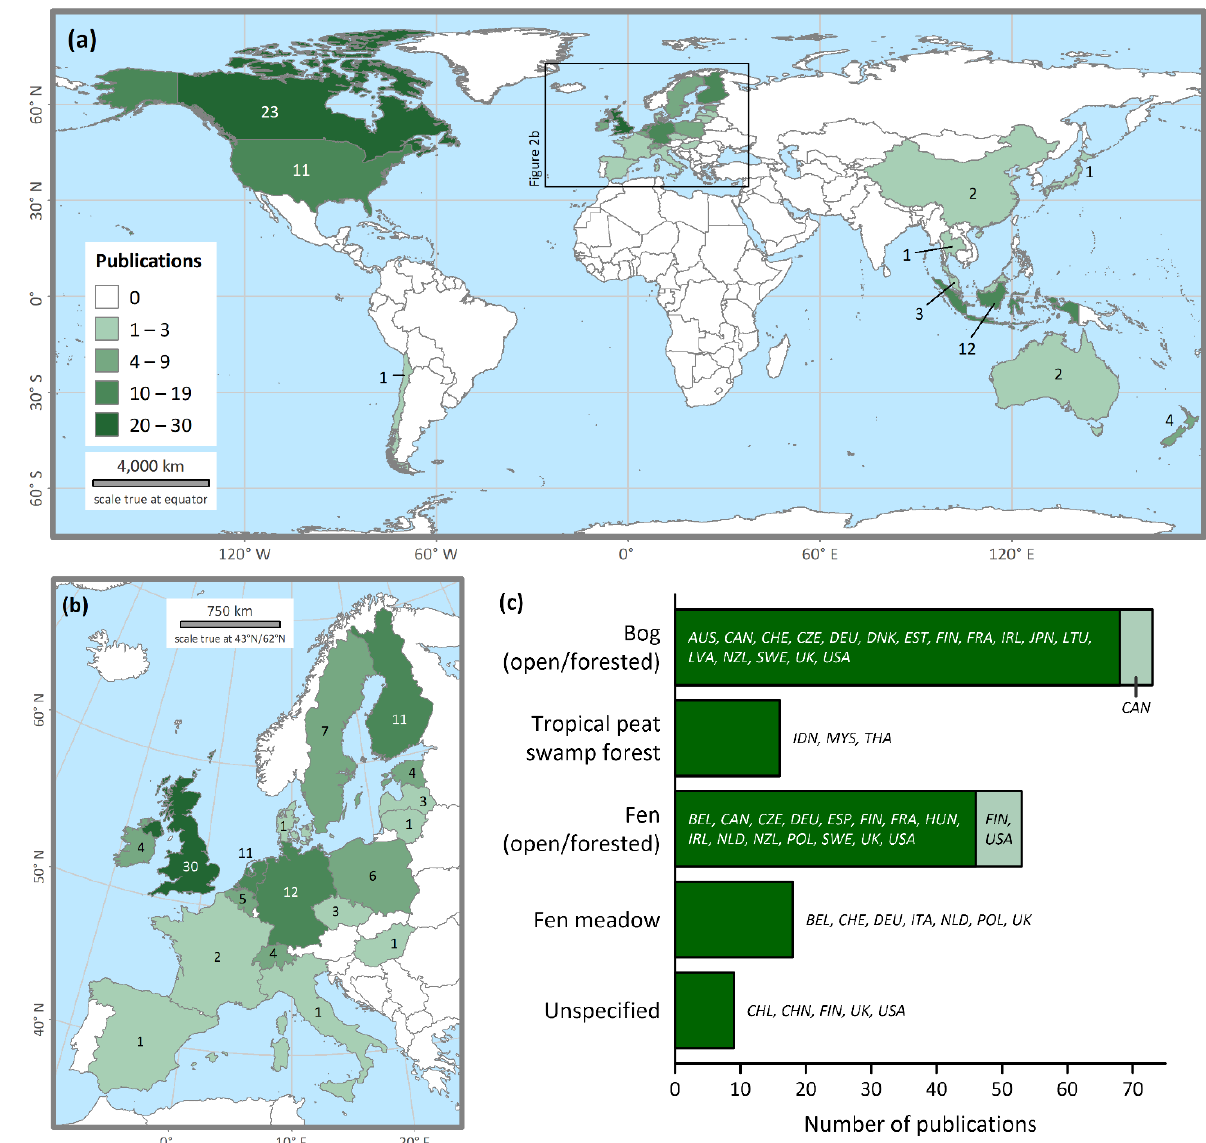
Figure 2. Distribution of publications in the Peatland Evidence Synthesis (a) globally, (b) in Europe, and (c) by habitat type. Publications could contribute more than one country or peatland type to the dataset. Hence, 162 publications generated 167 country data points and 169 habitat type data points. In (c), countries